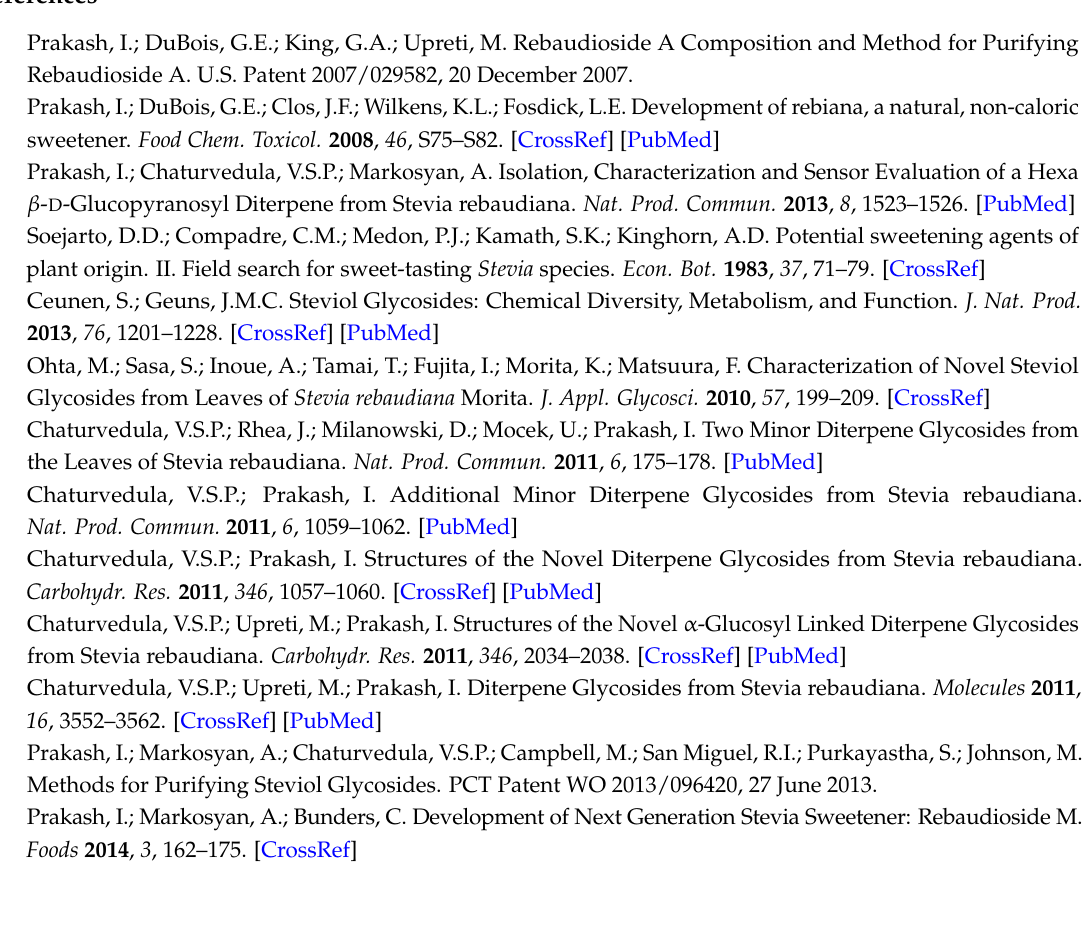
Figure S1: Preparative HPLC trace from primary chromatographic process, Figure S2: Preparative HPLC trace from second chromatographic process, Figure S3: Preparative HPLC trace from third chromatographic process, Figure S4: 1 H Nuclear Magnetic Resonance (NMR) spectra, full scale and expansions of Rebaudioside IX ( 1 ), Figure S5: 13 C NMR spectrum of Rebaudioside IX ( 1 ), Figure S6: 1 H- 1 H Correlation Spectroscopy (COSY) spectrum of Rebaudioside IX ( 1 ), Figure S7: 1 H- 13 C Heteronuclear Single Quantum Coherence-Distortionless Enhancement Polarization Transfer (HSQC-DEPT) spectrum of Rebaudioside IX ( 1 ), Figure S8: 1 H- 13 C Heteronuclear Multiple Bond Correlation (HMBC) spectra, full scale and expansion of Rebaudioside IX ( 1 ), Figure S9: 1 H- 1 H Nuclear Overhauser Effect Spectroscopy (NOESY) spectrum of Rebaudioside IX ( 1